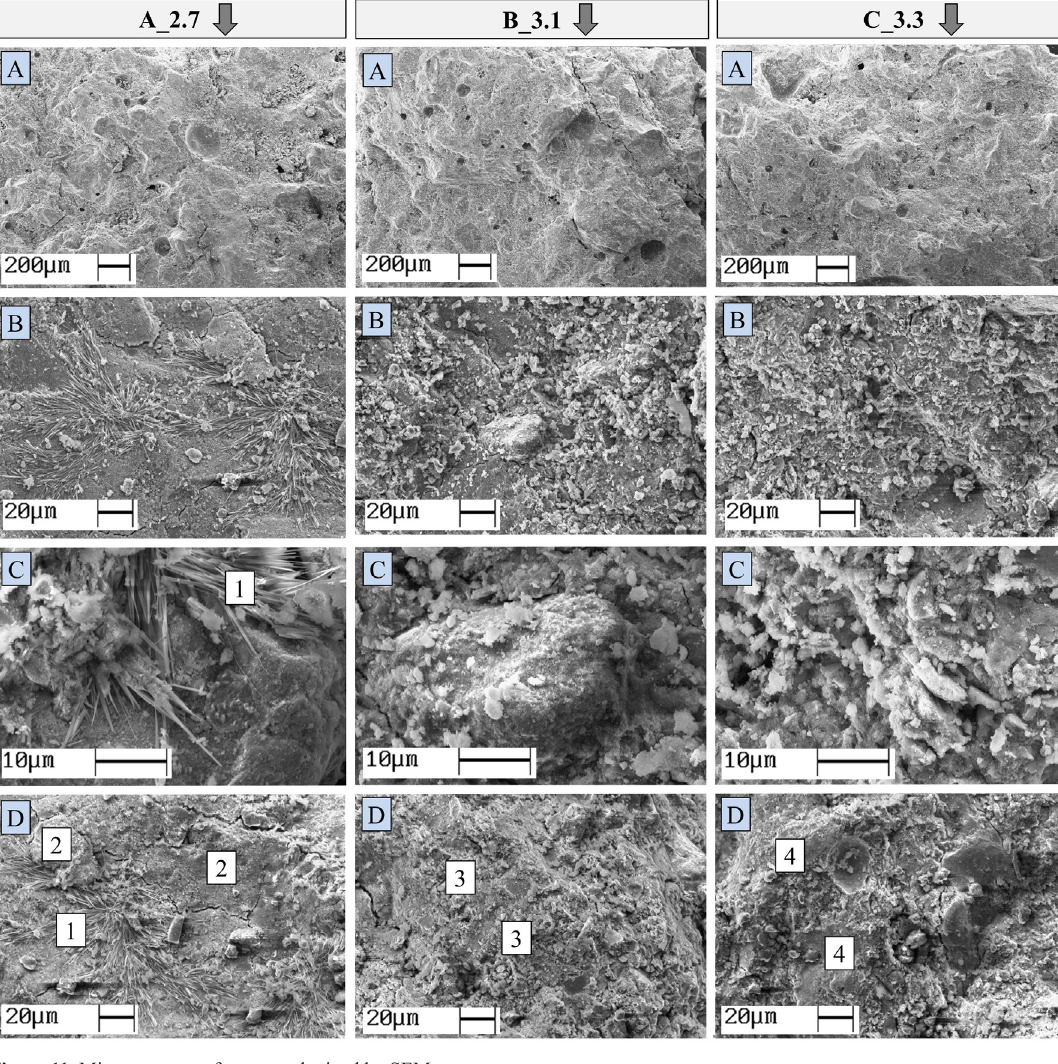
Figure 11. Microstructure of mortars obtained by SEM. Table 6. Elemental composition of mortars (obtained by EDS).